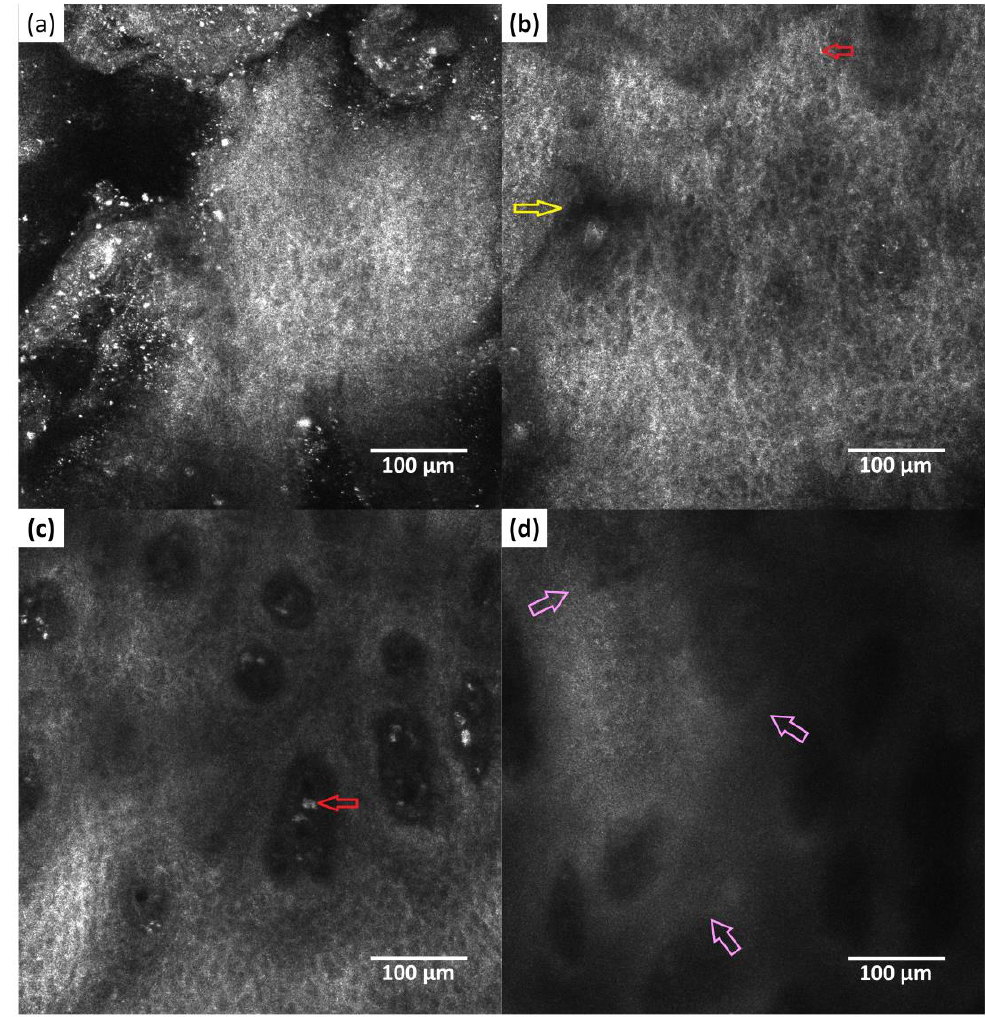
Figure 3. Reflectance confocal microscopy (RCM) images (500 × 500 µ m) of the atopic skin—right antecubital fossae ( a ) cornified layer; ( b ) granular/spinous layer with irregular cells, intercellular inflammatory infiltrate (red arrow) and spongiosis (large dark areas) (yellow arrow); ( c ) blurred image of the dermo-epidermal junction with irregular or even absent papillary rings, disappeared cellular borders and furthermore, inflammatory cells inside the dermal papillae (red arrow); ( d ) dermis with elastic and collagen fibers with the appearance of a blurred reticulated meshwork (purple arrow).